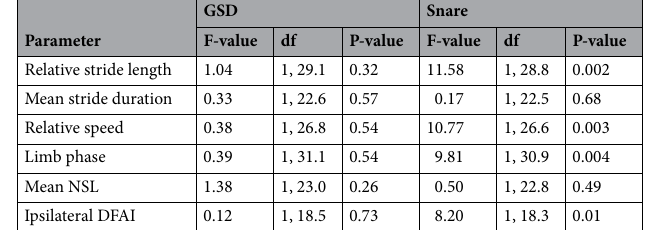
Table 4. Effects of GSD and snare injuries on spatiotemporal limb kinematics in free-ranging Nubian giraffe Giraffa camelopardalis camelopardalis from Murchison Falls National Park, Uganda.